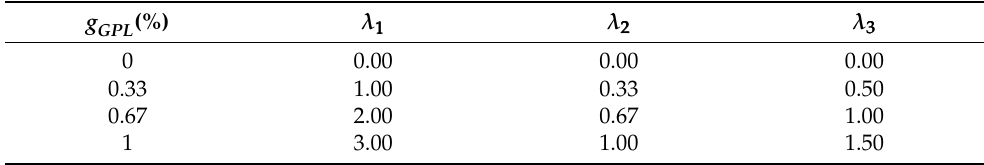
Table 2. Values of GPL weight fraction indices.